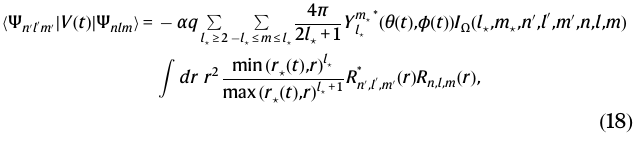
Fig. 7 for m pert =2. As for the accretion disk perturbations, we fi nd that for α ≳ 0.1 the cloud is unlikely to be disrupted.